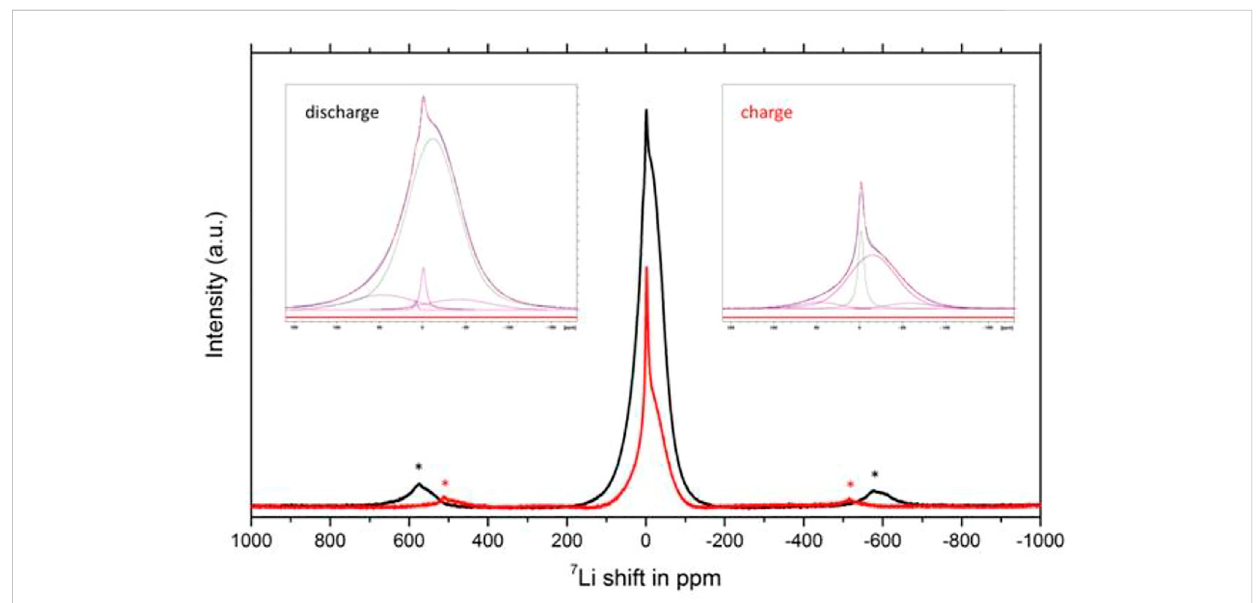
FIGURE 5 Ex situ 7 Li MAS NMR spectra collected on discharged (black) and charged (red) V corresponding deconvolutions of the